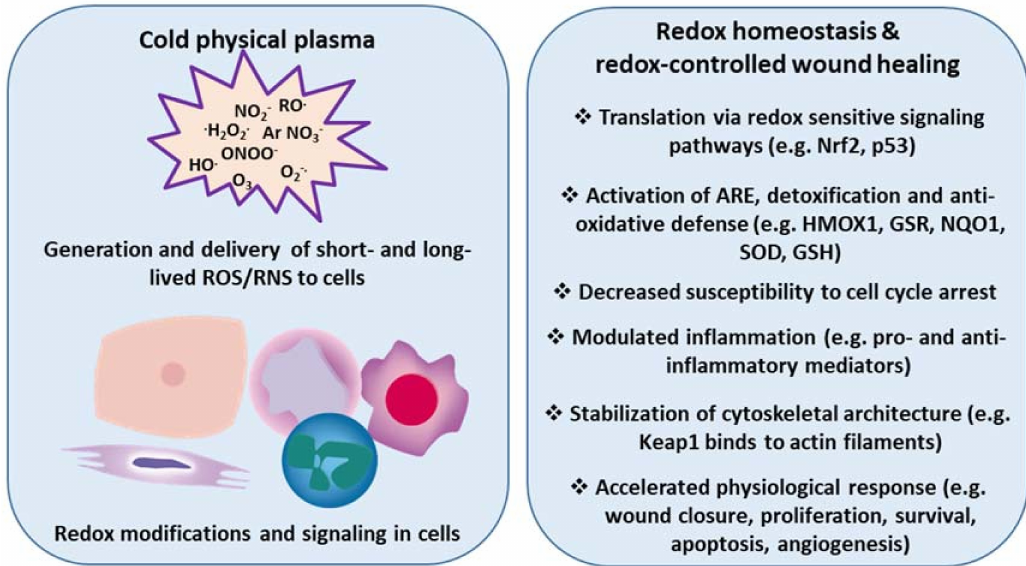
Figure 3. Cold physical plasma-derived generation and delivery of ROS/RNS triggers redox modifications and accelerates physiological responses in wound healing. Redox sensitive signaling pathways (e.g., Nrf2, p53) provide protection from excess ROS/RNS to eventually re-establish redox homeostasis. Cold physical plasma-derived ROS/RNS are efficient triggers of such signaling events in skin cells in vitro and in vivo. Accordingly, plasma treatment promotes several cellular and tissue responses linked to molecular signatures accompanying enhanced wound